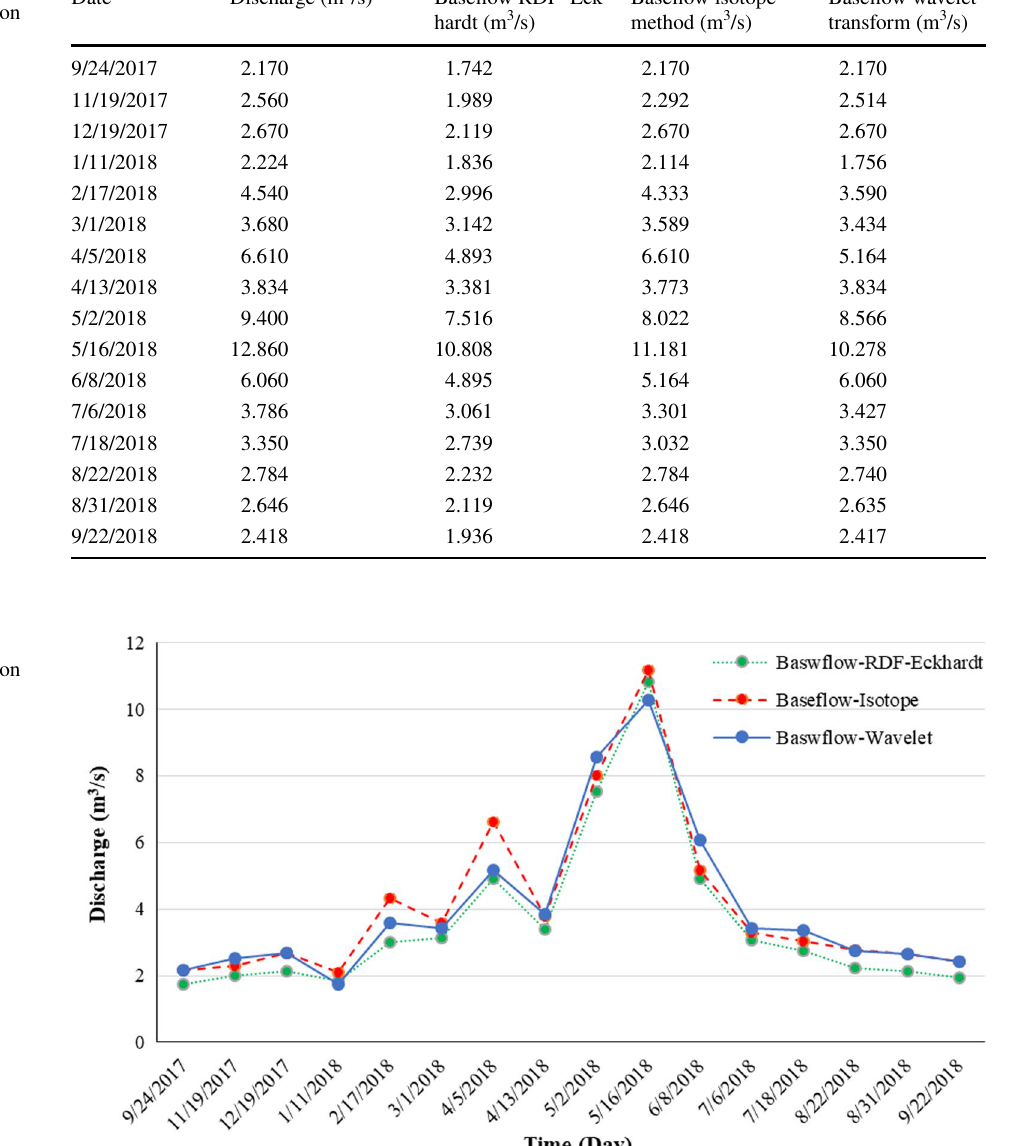
Table 13 Comparison of used methods of baseflow separation in the water year 2017–18